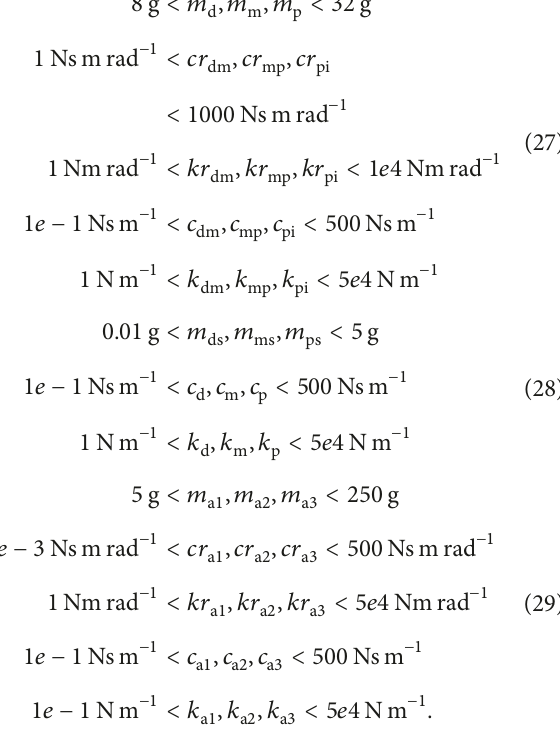
The constraints for all three models are presented below: Table 1: The 𝑅 2 values, model undamped natural frequencies, and the lengths of the different elements in each model. The lengths were determined prior to the data fitting from anthropometric